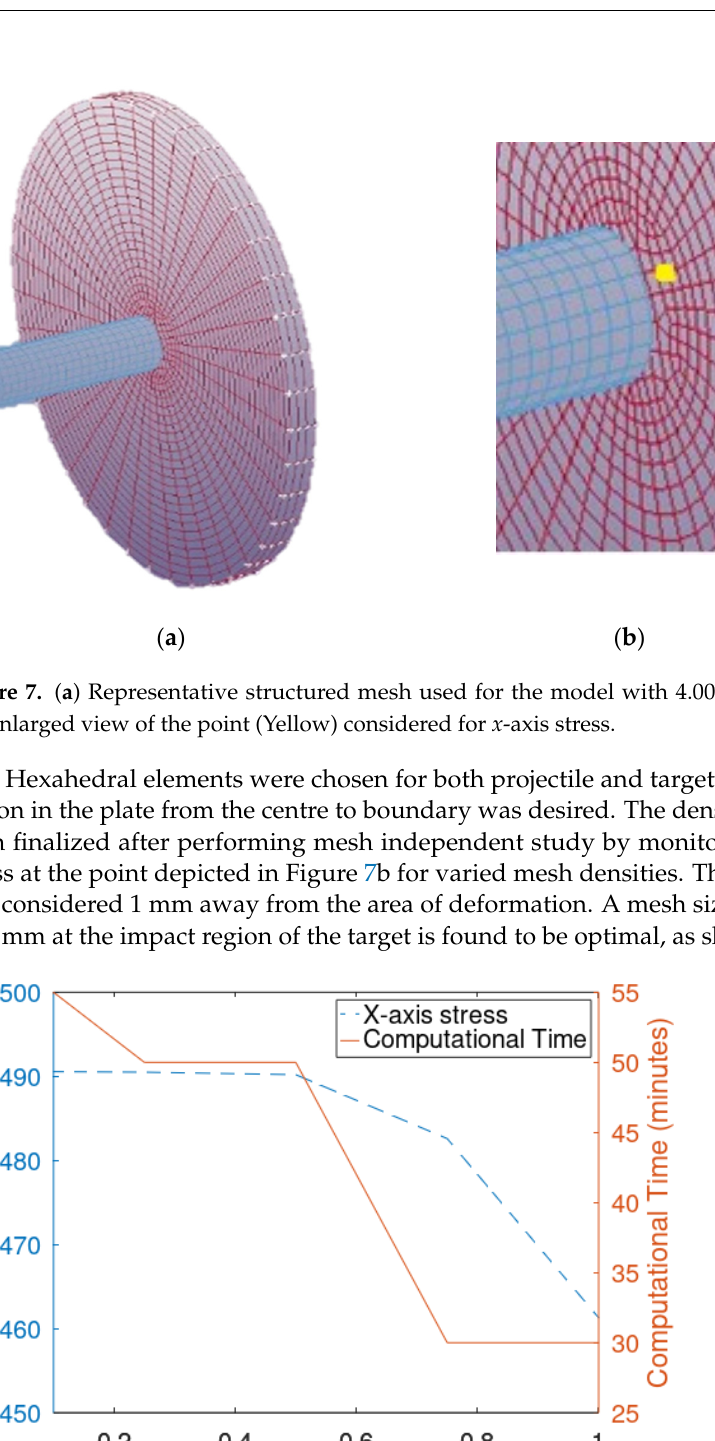
Figure 8. Mesh independent study with respect to element size and corresponding computational time. tional